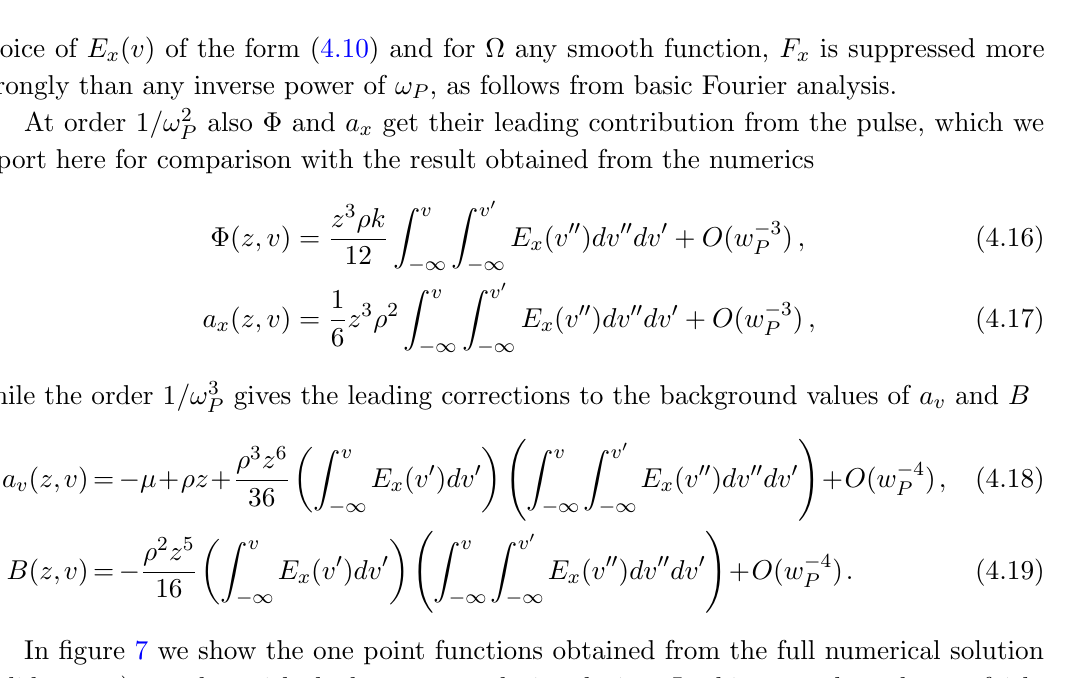
Figure 7 . One point functions from the full numerical solution (solid) compared to the analytic large ! P approximation at leading order (dashed), for ! P = 0 :